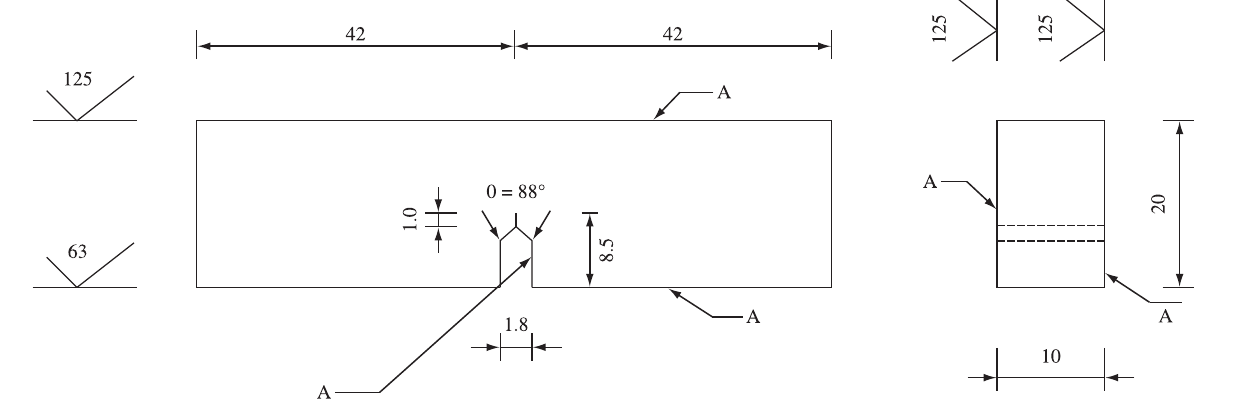
Figure 7. SE (B) specimen dimensions and geometry used for fracture toughness tests. Dimensions are in mm.